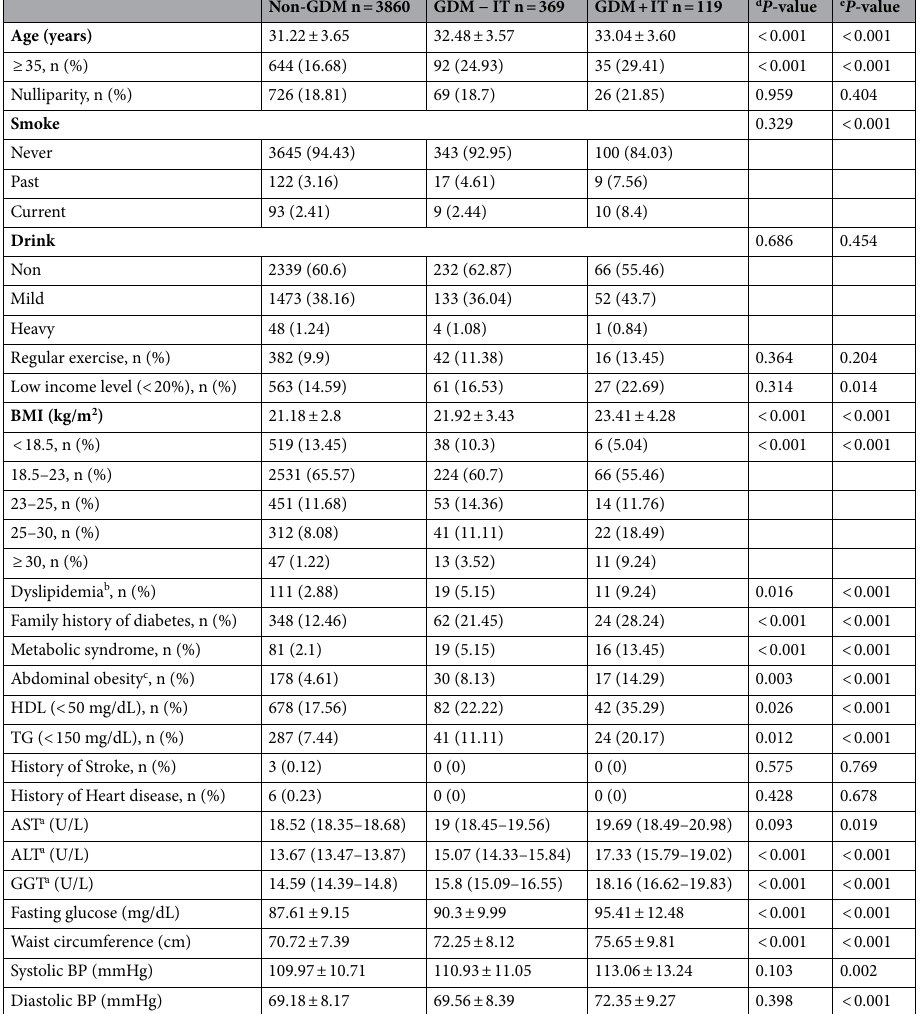
Table 1. Characteristics of the study participants. Values are expressed as mean ± standard deviation, n (%), or a geometric mean (95% confidence interval). b Dyslipidemia included known treatment for hyperlipidemia. c Abdominal obesity was defined as high waist circumference (≥ 85 cm). d p -value: significance probability between non-GDM group and GDM − IT group. e p -value: significance probability between non-GDM group and GDM + IT group. GDM gestational diabetes mellitus, BMI body mass index, HDL high-density lipoprotein, TG triglyceride, AST aspartate aminotransferase, ALT alkaline phosphatase, GGT gamma glutamyltransferase, BP blood pressure. Non-GDM pregnant women without GDM, GDM − IT GDM pregnant women without insulin treatment, GDM + IT GDM pregnant women with insulin